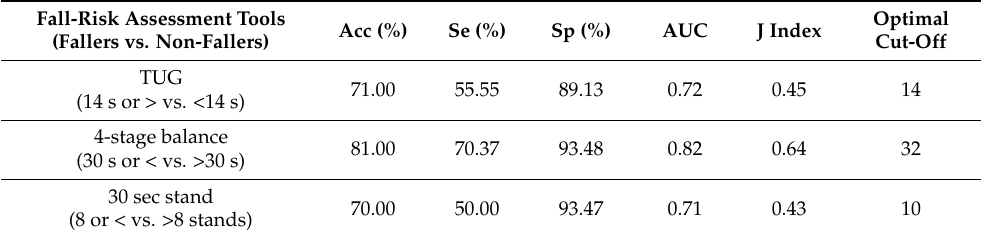
Optimal Cut-Off